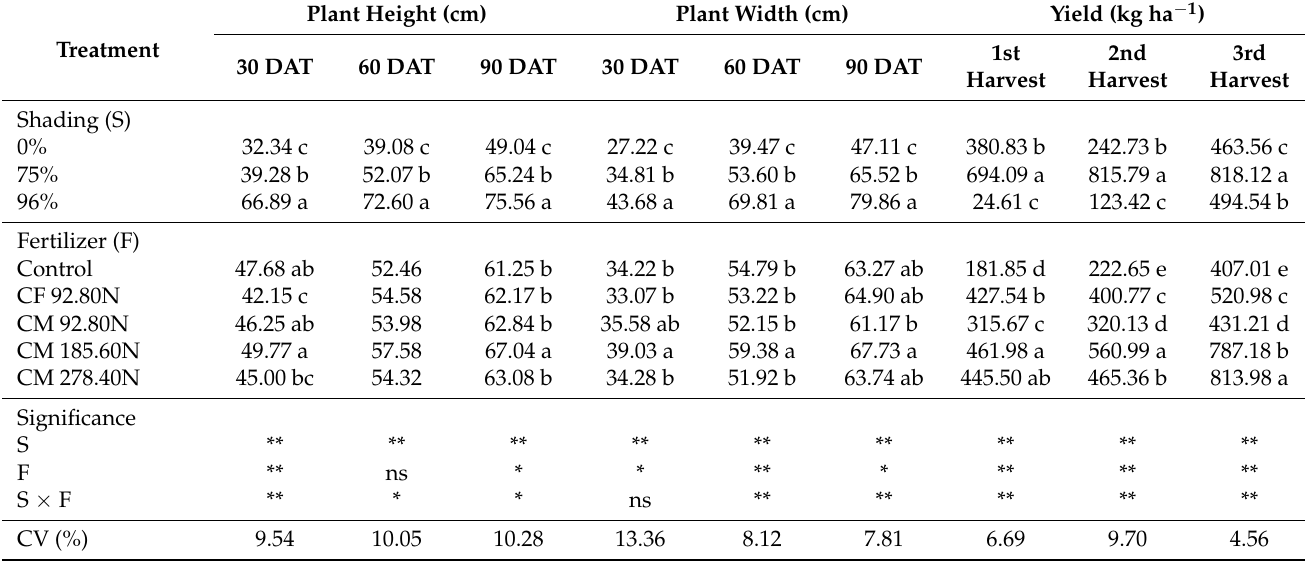
Table 3. Growth at 30, 60 and 90 days after transplanting (DAT) and yield at first (90–120 DAT), second (121–150 DAT), and third (151–180 DAT) harvests of vegetable fern grown under different treatments of shading and fertilizer application.